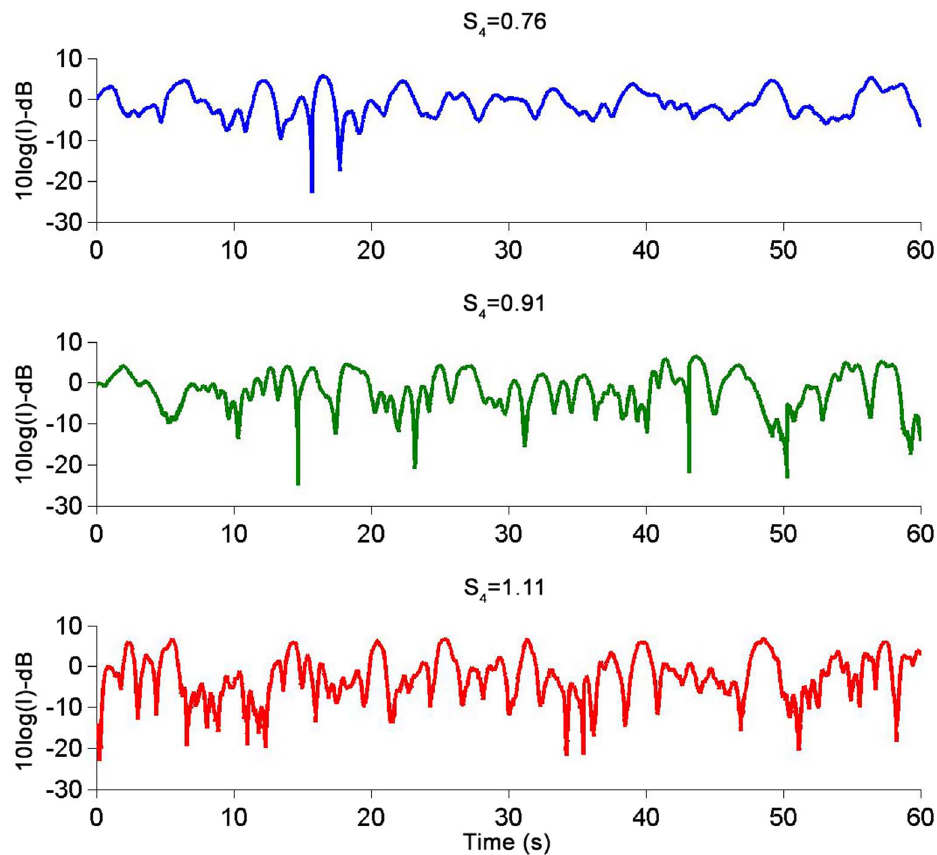
Fig. 3. Three examples of scintillation data showing how the signal quality degrades according to the S 4